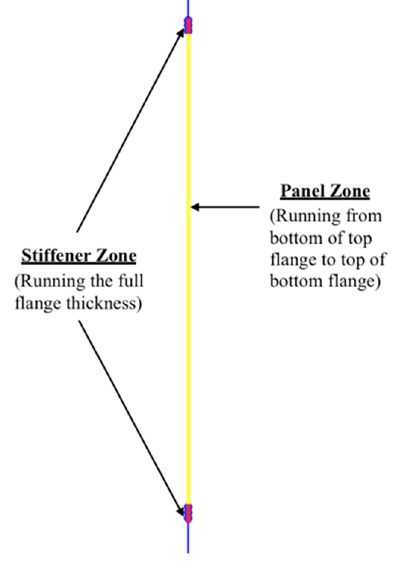
Figure 3. Column stiffener and panel zones.